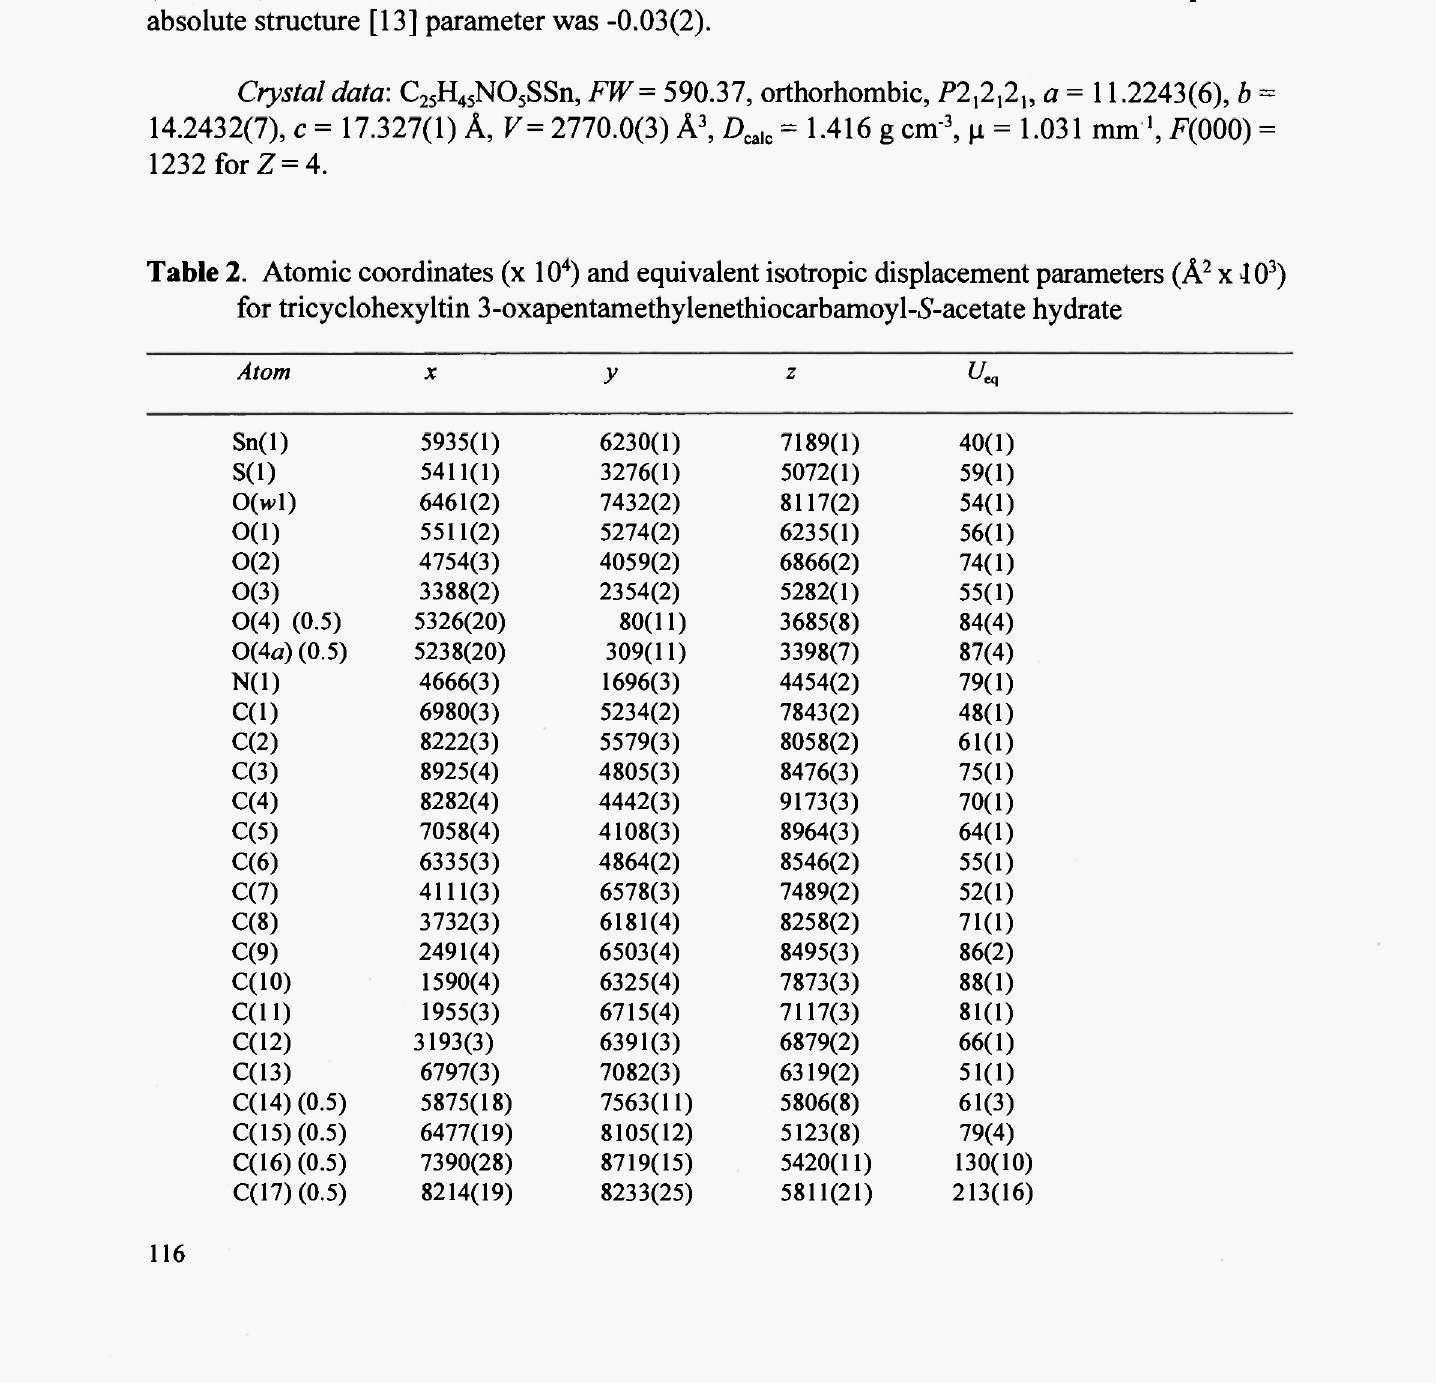
Table 2. Atomic coordinates (χ 10 4 ) and equivalent isotropic displacement parameters (A 2 χ 4 0 3